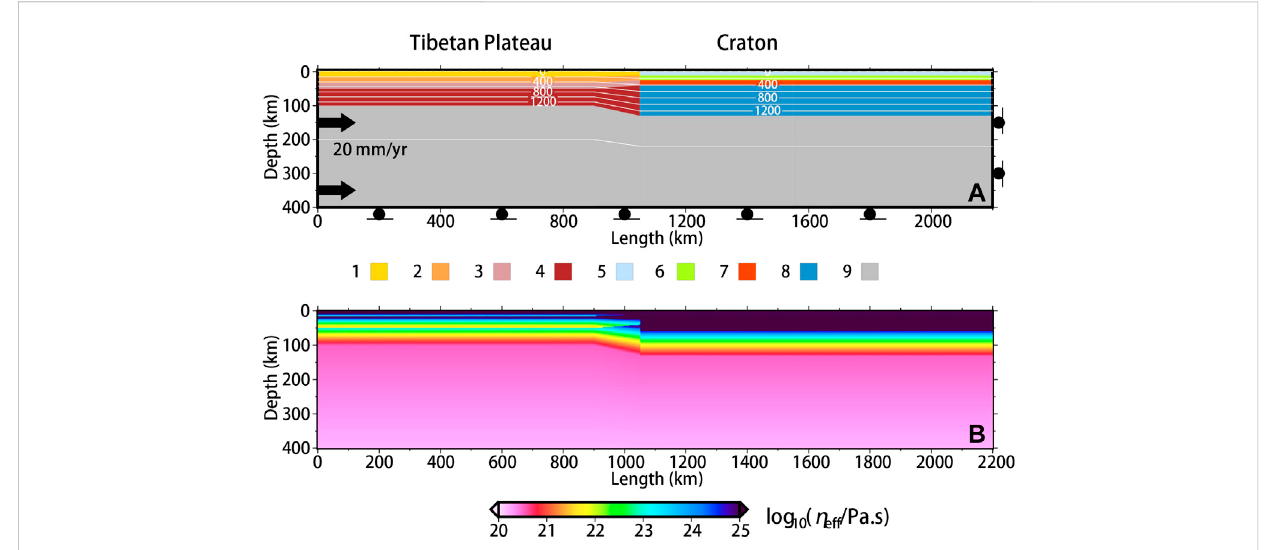
FIGURE 2 The two-dimensional fi nite element model and boundary conditions (A) and the initial effective viscosity of the reference model (case R) (B) . Differentcolorsin (A) indicatedifferentmaterials.Units1 – 4aretheuppercrust,middlecrust,lowercrust,andmantlelithosphereoftheTibetanPlateauor a weak orogen in other cases, respectively; units 5 – 8 are the upper crust, middle crust, lower crust, and mantle lithosphere of the craton or a strong orogen in the craton, respectively (Table 1); unit 9 is the asthenosphere. White lines in (A) indicate the initial